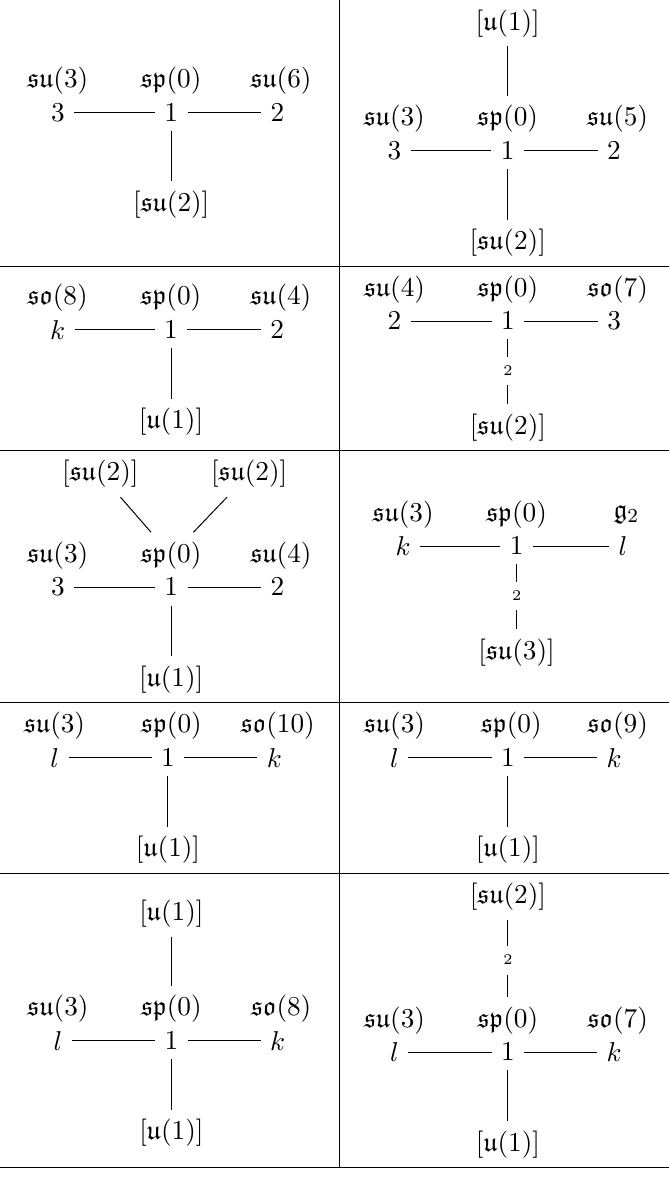
Table 4 . Possible localized flavor symmetries for nodes with a trivial gauge algebra continued from table 3. Continued further in table